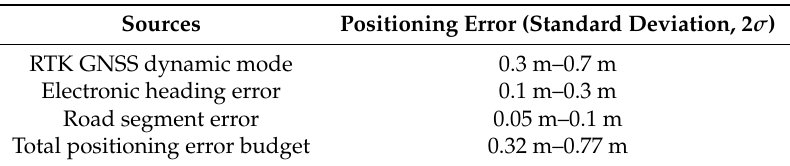
Table 1. Error budget for the related sources.